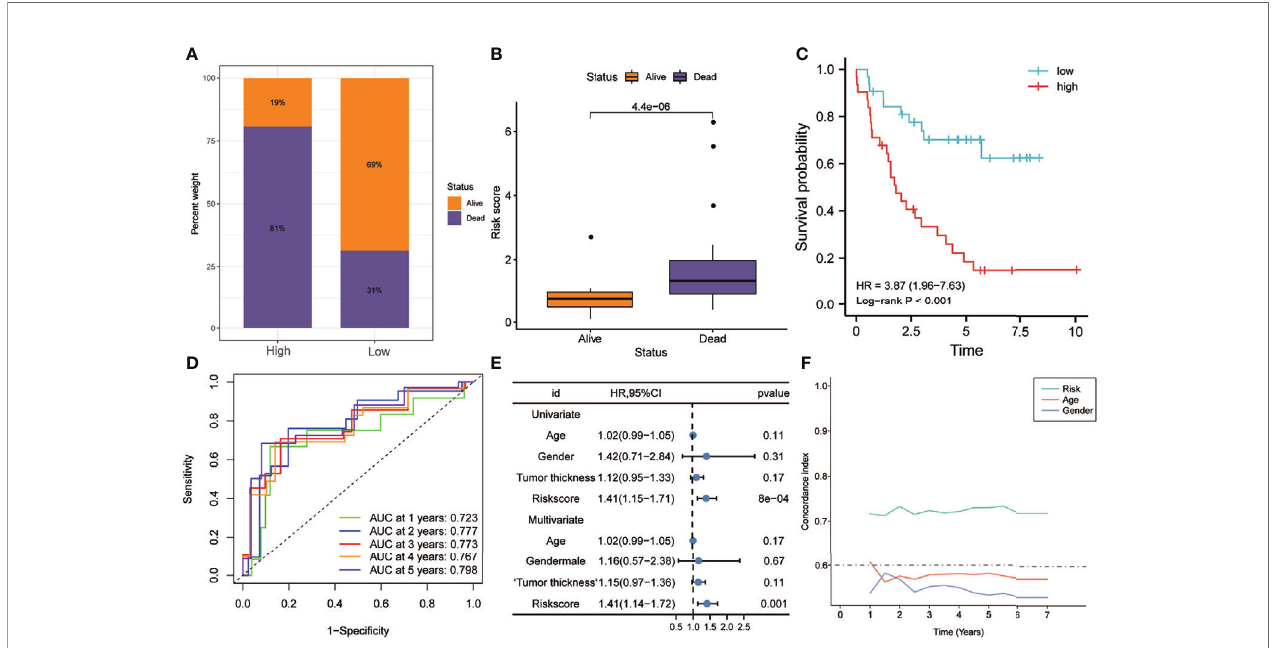
FIGURE 6 | Validation of the risk model in the GSE22138 dataset. (A) Patients in the high-risk group had higher mortality rates. (B) The risk scores of patients who died during follow-up were higher. (C) Kaplan – Meier analysis showed that patients with higher risk scores had worse overall survival. (D) The ROC curve showed good predictive accuracy of the risk score for OS (AUC > 0.7). (E) Univariate and multivariate Cox regression analyses showed that risk score was an independent risk factor for OS. (F) The t-ROC analysis showed that the survival predictive power of the risk model was signi fi cantly better than that of other clinical features. AUC , area under the ROC curve; HR , hazard ratio; OS , overall survival; t-ROC , time-dependent receiver operating